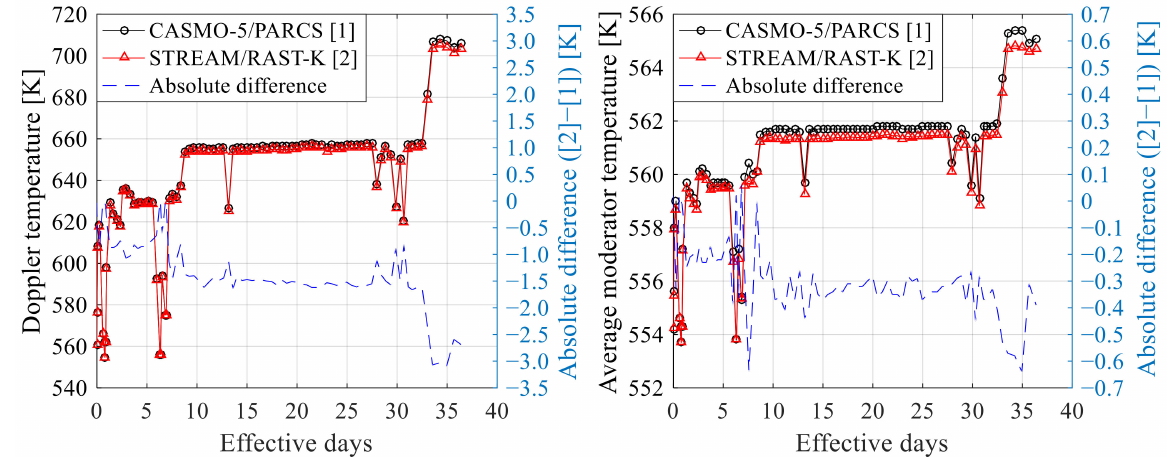
Figure 22. T/H Feedback—inlet, flowrate, fuel temperature (doppler).